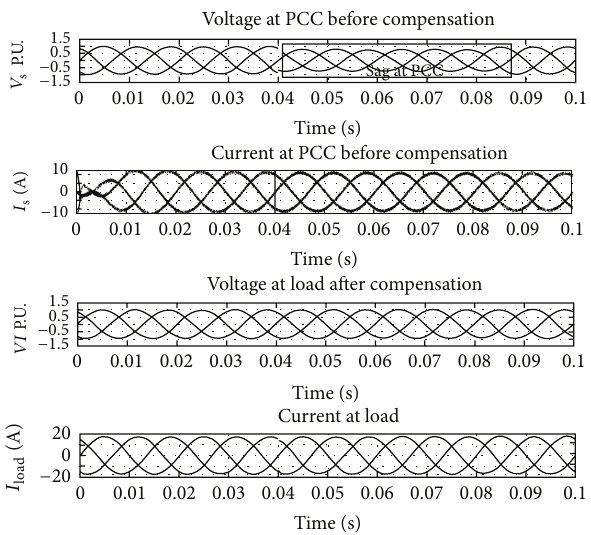
Figure 7: Output of source voltage and current and load voltage and current waveform.